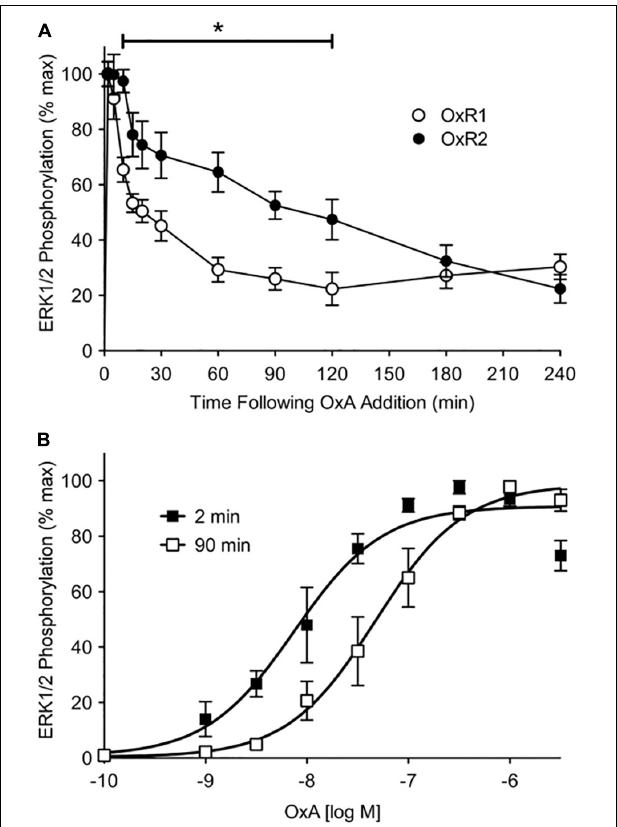
FIGURE 2 | ERK1/2 phosphorylation data for OX 1 R (OxR 1 ) and OX2R (OxR 2 ) stably transfected in HEK293 cells. (A) Stably transfected HEK293 cells were treated with OX-A (OxA) and measured over a 4-h period. Data were normalized to time-matched vehicle treatments and are expressed as a percentage of the maximal response induced at 2 min post-agonist treatment. Data are expressed as mean ± SE of four independent experiments. * p < 0.05 between OX 1 R and OX 2 R from 10 to 120 min post-agonist stimulation. (B) Concentration-response data were collected at 2- and 90-min post OX-A treatment of OX 2 R-expressing cells. Data are expressed as a percentage of the maximal response induced at the time point (mean ± S.E. of four independent experiments). Reproduced from Dalrymple et al. (2011) under a Creative Commons Attribution 4.0 International License. Full terms provided at